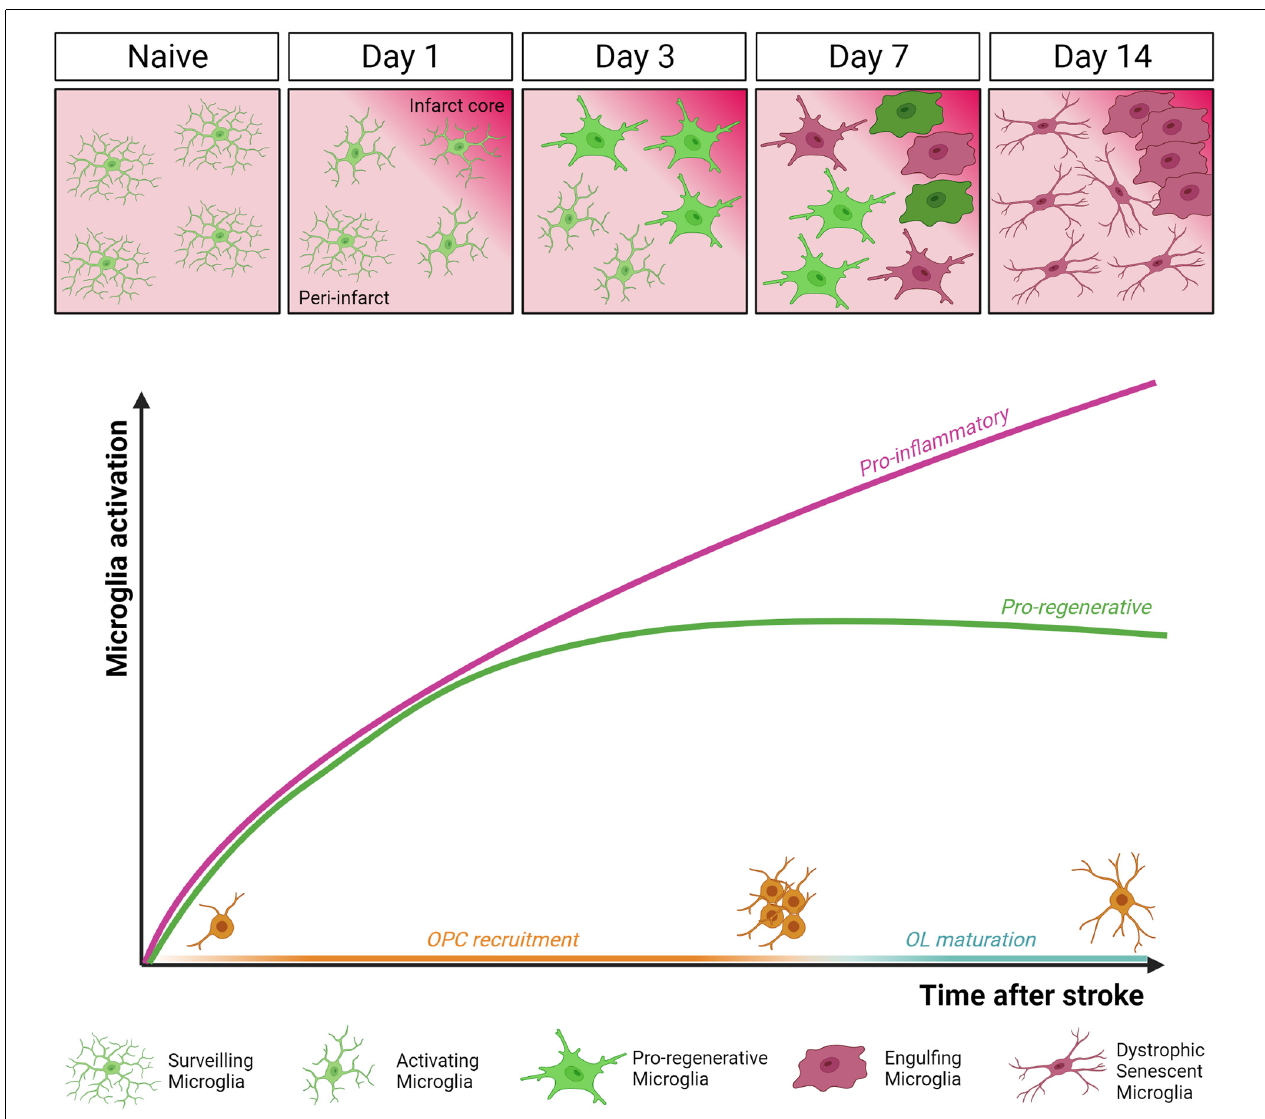
FIGURE 2 | Dynamics of microglia activation after stroke. In the intact brain (Naïve), microglia display highly ramified morphology and fast process motility to surveil the surrounding tissue, as sentinels for danger signals. This allows microglial cells to rapidly respond to an ischemic event by undergoing profound morphological, molecular, and functional modifications. Two distinct temporal windows in microglial response following stroke have been defined. In the early phase (day 3 post-MCAo), microglial cells accumulating at the border of the ischemic lesion appear ameboid and hypertrophic, express both pro-inflammatory and pro-regenerative markers, and have high phagocytic capacity. At this stage, microglia were found to actively contribute to remyelination by favoring oligodendrocyte precursor cells (OPCs) recruitment and preserving myelin integrity (Raffaele et al., 2021). Conversely, at late stage after stroke (day 14 post-MCAo),